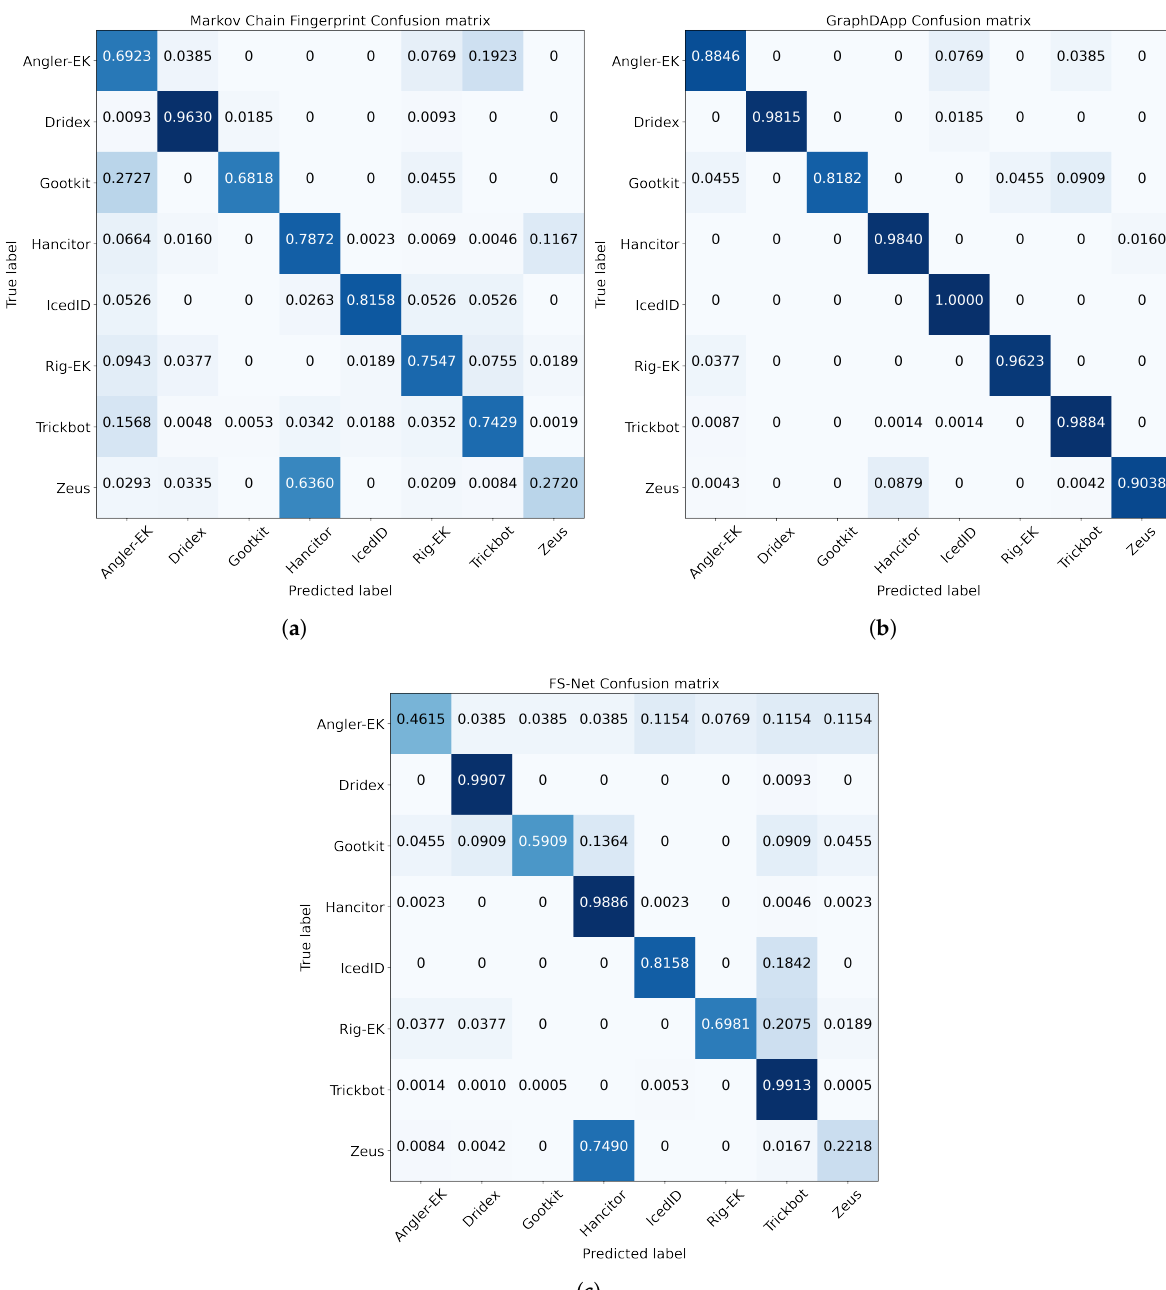
Figure 4. Confusion matrices of classification results using ( a ) Markov chain fingerprinting with maximum likelihood classifier, ( b ) traffic interaction graph with fully connected layer classifier (GraphDApp), and ( c ) embedding vector with